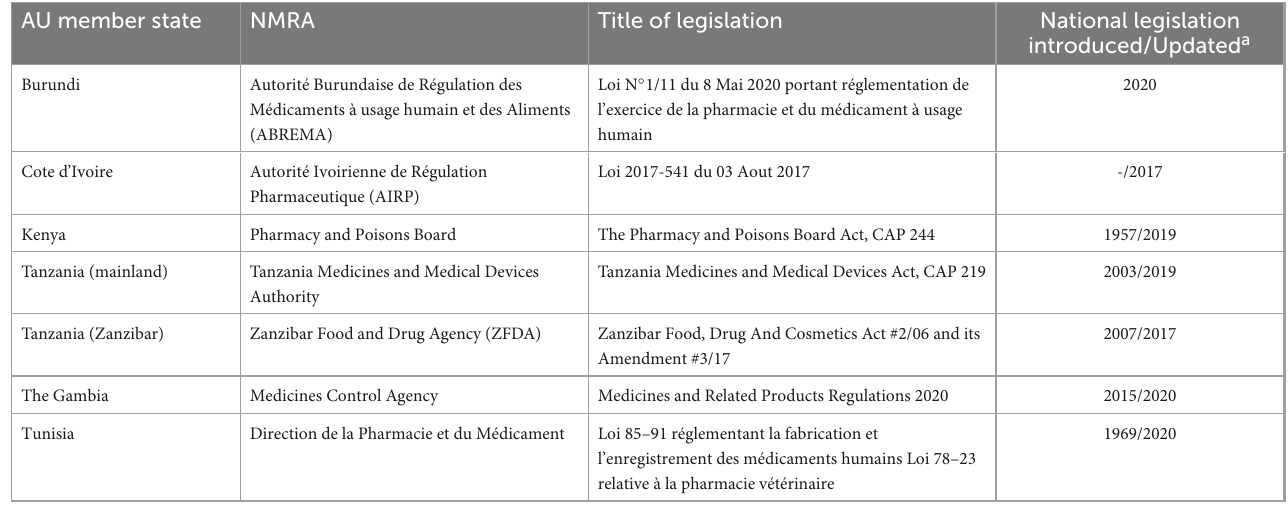
TABLE 1 Study countries that have domesticated the AU Model Law ( n =